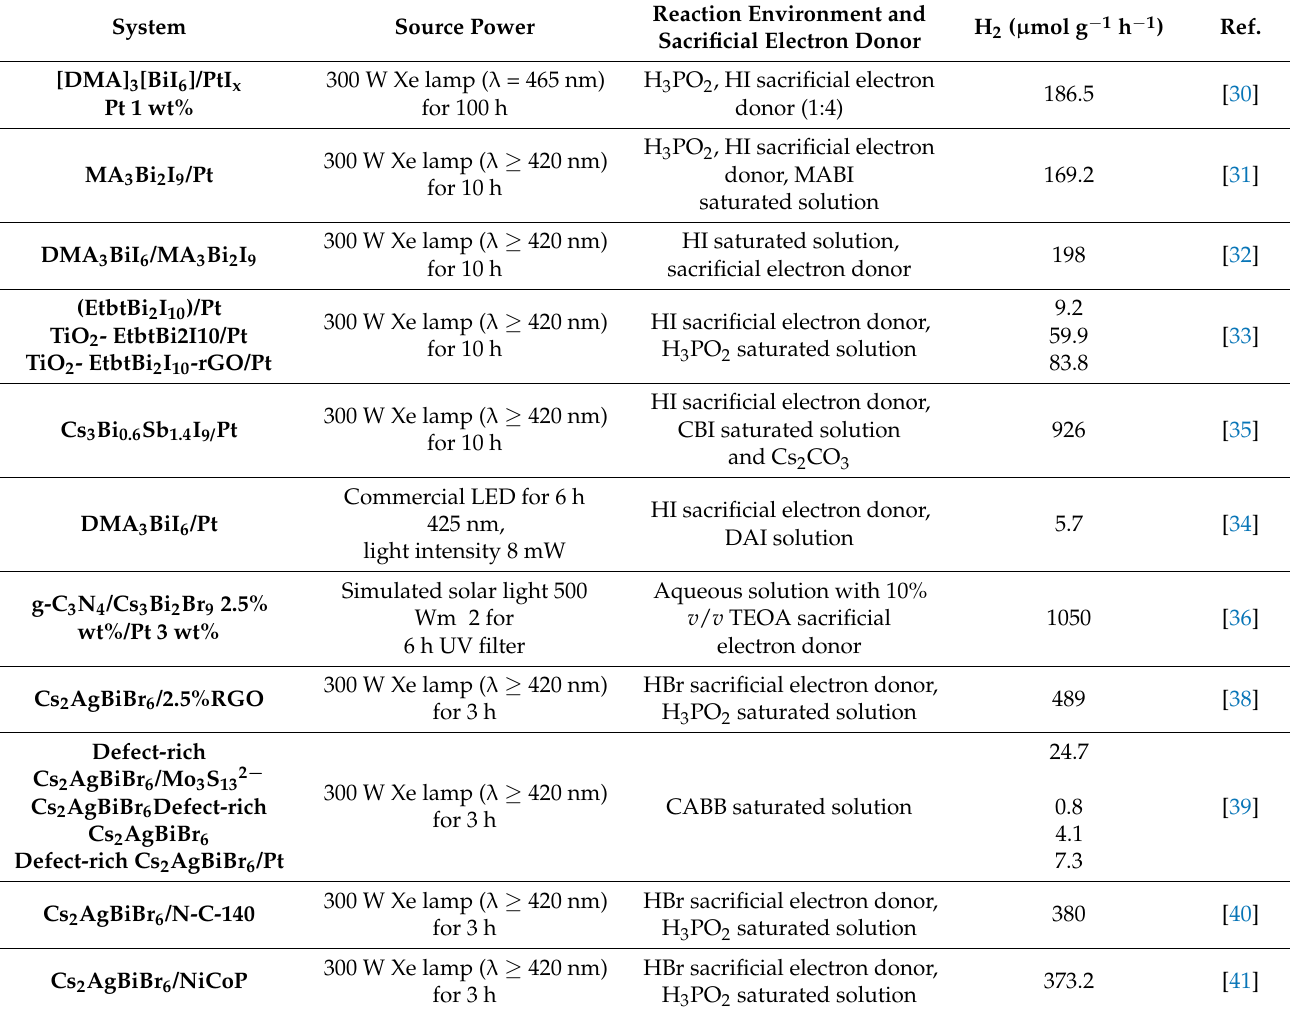
Table 1. Summary of the photocatalytic Bi-based halide perovskite systems discussed in this review. System